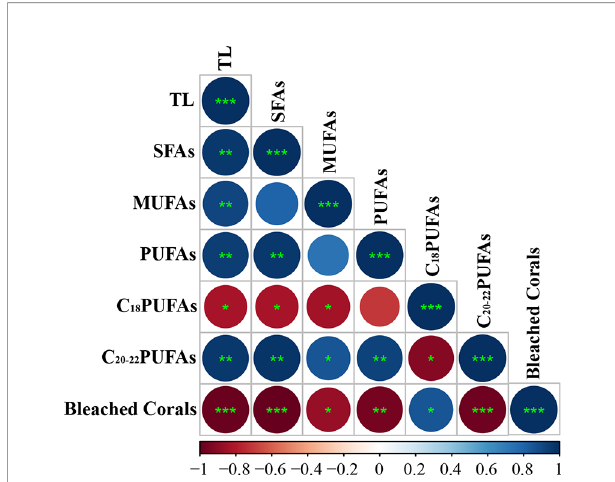
Values are mean ± SD. MUFAs, monounsaturated fatty acids; PUFAs, polyunsaturated fatty acids; SFAs, saturated fatty acids; “ − ” , not detected.